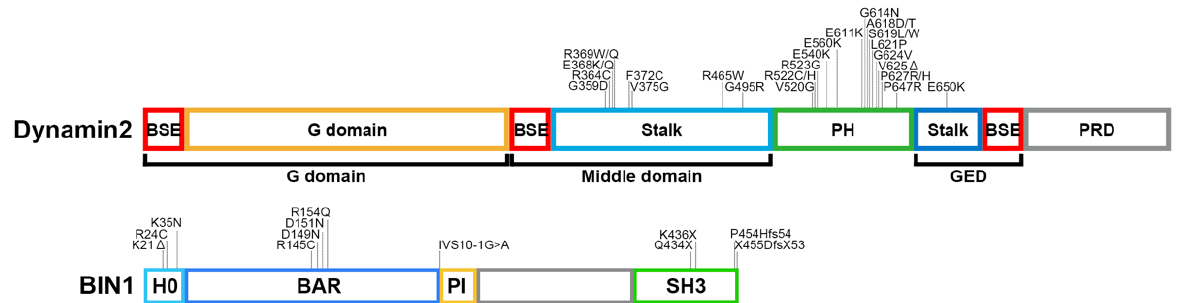
Figure 2. Domain structures of dynamin 2 and BIN1. Schematic illustrations of domain structures and CNM-associated mutations in dynamin 2 and BIN1.